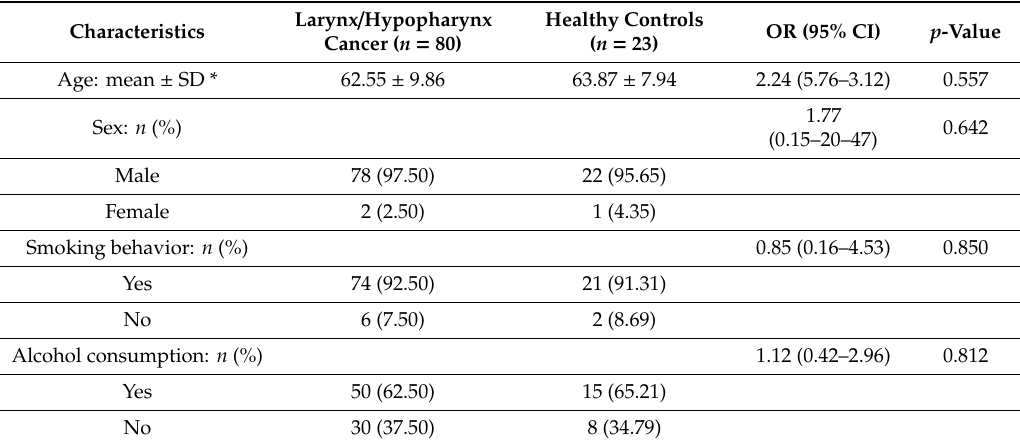
Table 1. Study groups’ demographic characteristics and smoking and alcohol habits (Student t-test and Pearson χ 2 ).